Question: From the figure, is the trend upward or downward?
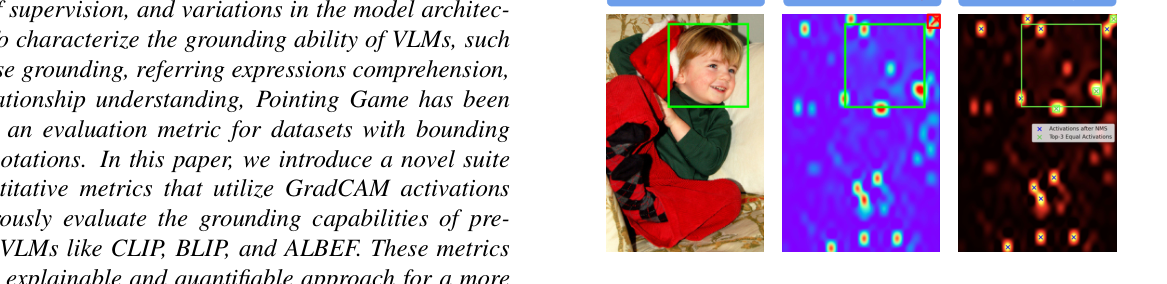
Answer: decreasing